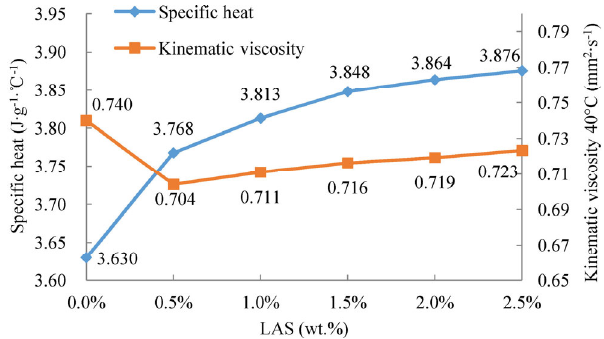
Fig. 8 Variation in the specific heat and kinematic viscosity of WO-S cutting fluids at 40